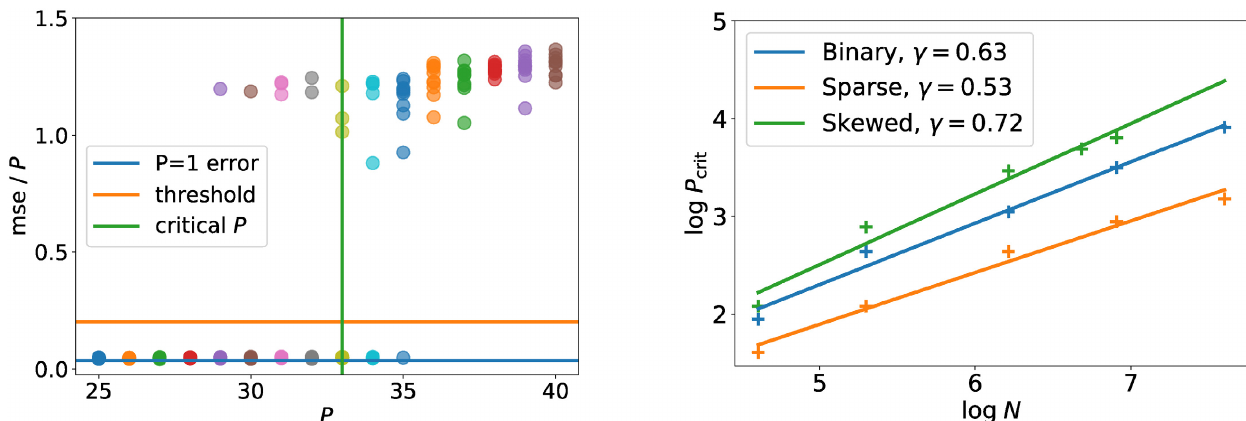
Fig 5. Scaling of the critical number of patterns that can reliably be reconstructed with mean-field message passing. (Left) For binary patterns, we plot the final reconstruction error of twenty instances of the mean-field message-passing algorithm as a function of the number of stimuli stored P . We define the critical number of patterns that can be reconstructed as the largest P at which more than half the runs yield an mse better than a threshold value (here, 20% of the trivial mse , i.e. 0.2). Parameters: N = 1000, Δ = 0.2 Δ C , τ = 0. (Right) We plot the highest number of patterns P max that could be reconstructed with an error below 20% of the trivial error in at least 50% of cases. For all three models considered, we show experimental results (crosses) and the exponent of a power law fit P max * N γ . In all cases, τ = 0 and the noise level Δ was 20% of the critical noise level Δ where reconstruction becomes impossible. ρ = 0.3 for c both the sparse Hopfield and Tsodyk’s prior.